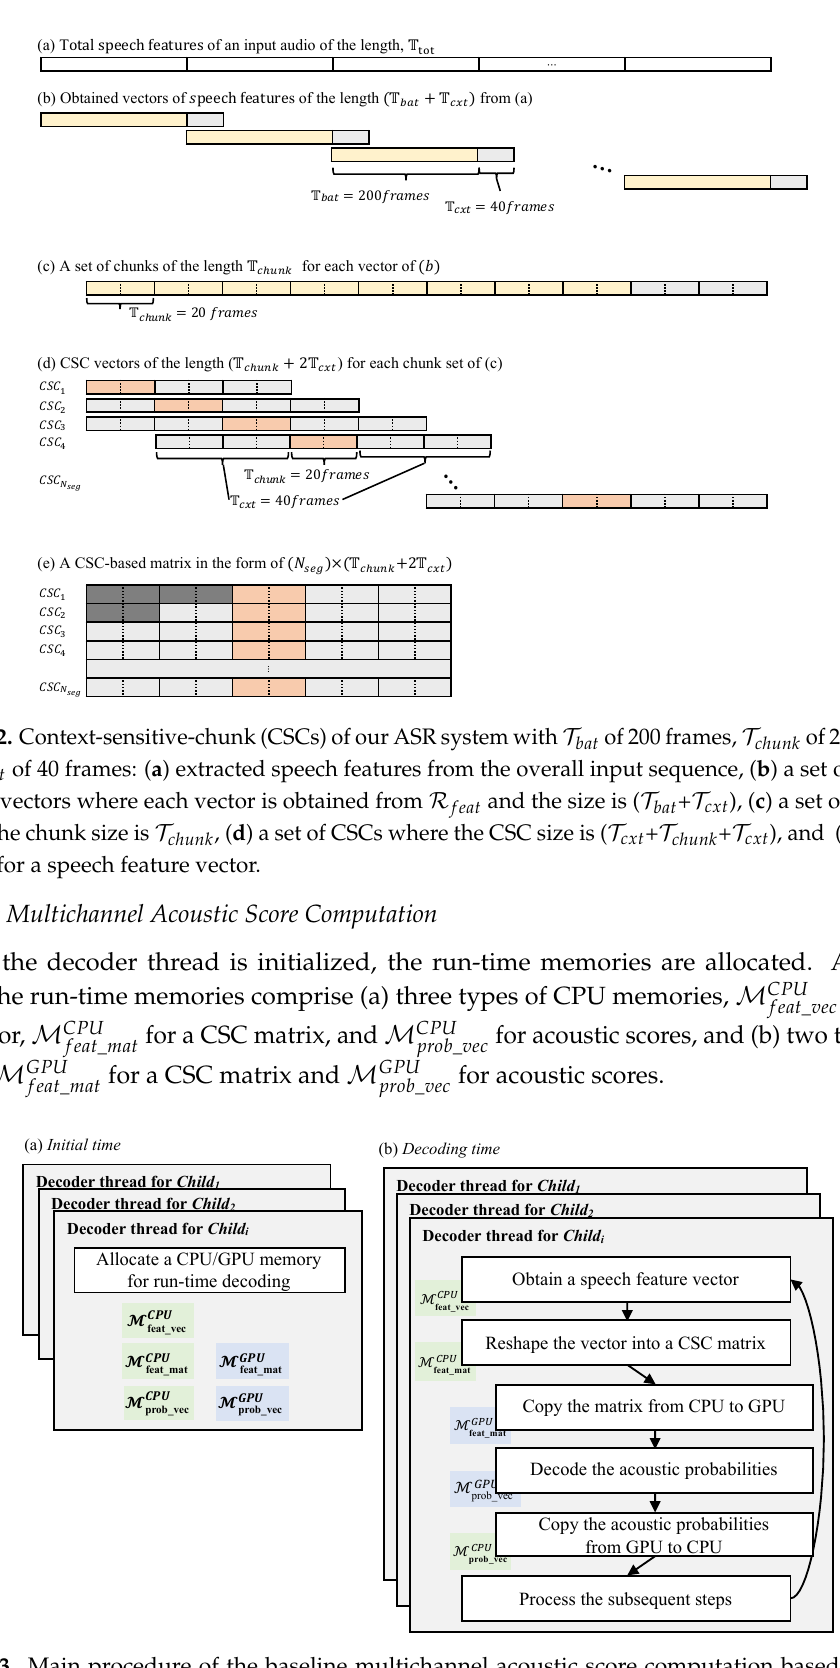
Figure 3. Main procedure of the baseline multichannel acoustic score computation based on CSC bidirectional long short-term memory acoustic model (BLSTM AM). The green- and blue-shaded boxes indicate the CPU and GPU memories,